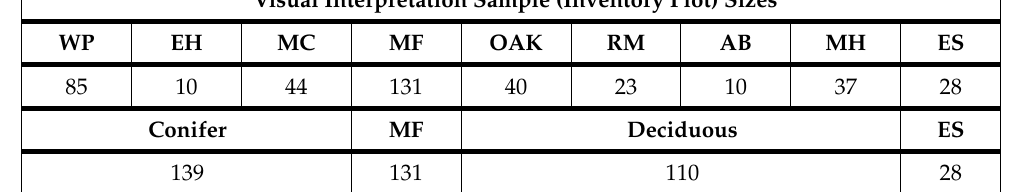
Table 1. Forest inventory plot sample sizes (in individual plots), for each composition class during both the nine-composition class visual interpretation and the generalized four-class visual interpreta- tion. Composition classes found within this table include white pine (WP), eastern hemlock (EH), mixed conifer (MC), mixed forest (MF), oak mixtures (OAK), American beech (AB), red maple (RM), mixed hardwoods (MH), and early successional